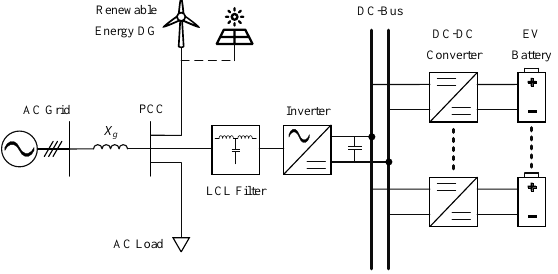
Figure 1. Schematic of renewables and EV integration with the grid. PCC, point of common